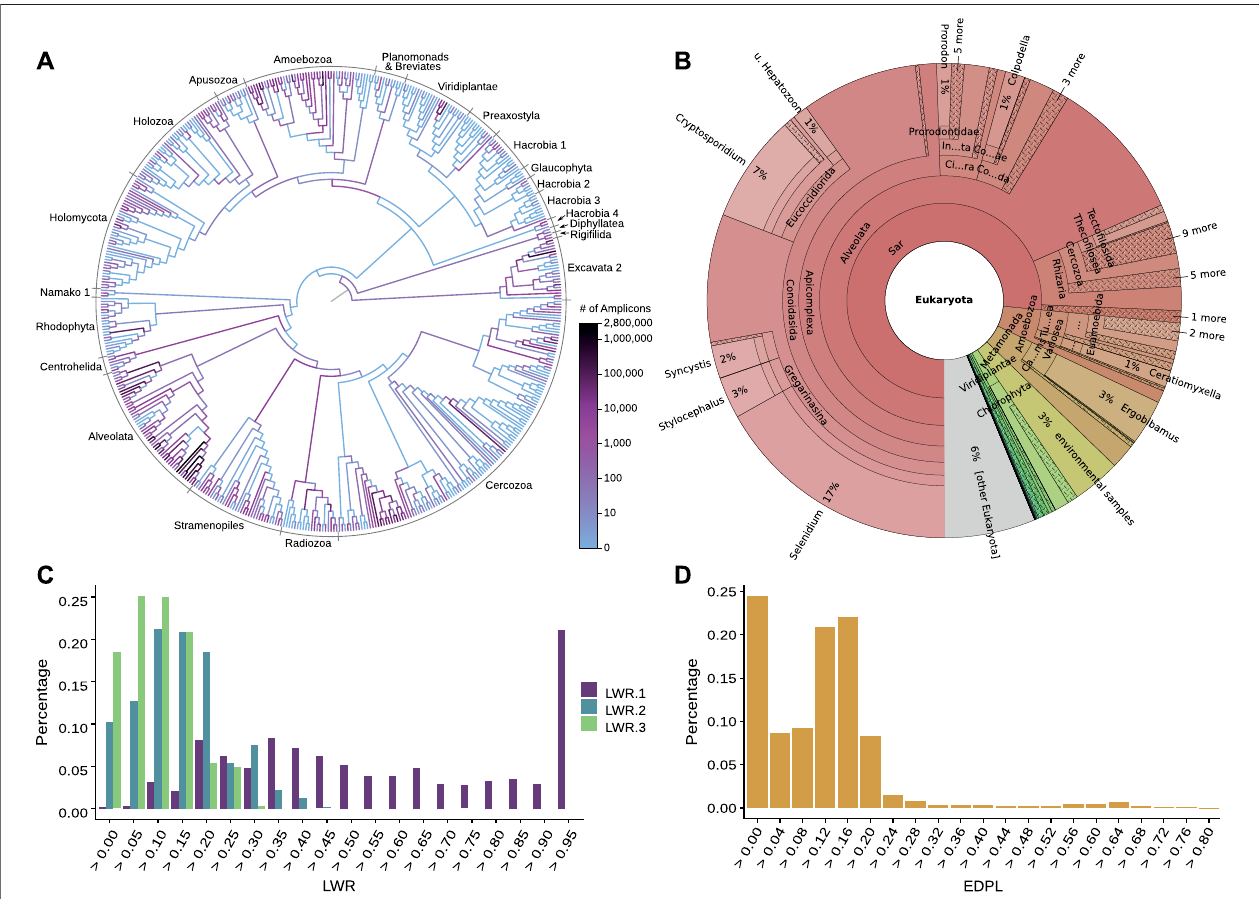
FIGURE 4 | Examination of phylogenetic placement data. Here, we show some techniques for visually inspecting placement data, using an exemplary dataset consistingof154soilsamplesfromneotropical rainforestsplacedonaneukaryotic referencetree(Mahéetal.,2017). (A) Heattreeshowingthedistribution ofmillionsof ampliconreadsonthereferencetreebysummingovertheper-branchLikelihoodWeightRatios(LWRs)ofallreads.Thehighabundanceofplacedreadsinthe Alveolata clade (dark branches in the lower left) visualizes a main fi nding of the dataset in form of an over-abundance of reads from that clade, shown in the phylogenetic contextofthereferencetree.Figureadapted from(Mahéetal.,2017). (B) Taxonomic assignmentofallreads basedonthePR 2 (Bensonet al.,2009;Guillouet al.,2012) taxonomy. The taxonomy of the reference sequences was used to label each branch of the reference tree by its highest non-con fl icting taxonomic path. Then, for each read, the LWRs of its placement locations were accumulated for the branches, creating an overview of taxonomic abundances taking placement con fi dences into account. The result across all reads is shown here as a Krona plot (Ondov et al., 2011). (C) Histogram of the LWRs of the fi rst three most likely placement locations of eachread,showinghowmanyofthereadshavetheir fi rst,second,andthirdmostlikelyplacementateach(binned)LWRvalue.Forexample,thehighestbinofLWR.1on the right hand side indicates that 20% of the reads have a fi rst (most likely) placement position at or above an LWR of 0.95. That is, these placements have a high LWR and are hence placed with high certainty onto their respective branches. Note that the second most likely placement (LWR.2) can never have an LWR exceeding 1/2 (otherwise, it would be the most likely), the third most likely (LWR.3) not more than 1/3 (otherwise, it would be the second most likely), and so forth. (D) Histogram of the Expected Distance between Placement Locations (EDPL), which are computed as the distances (in terms of ML branch path length) between placement locations of a query sequence, weighted by the respective LWR of each location. The EDPL measures how far the placements of a sequence are spread across the branches of the referencetree,and hence howcertain theplacementina “ neighborhood ” ofthetreeis.Here,most readshave anEDPL below0.24branch lengthunits(mean expected number of substitutions per site). This indicates that the reads have most of their likely placements close to one another, within two branches on average, given that the used reference tree has an average branch length of about